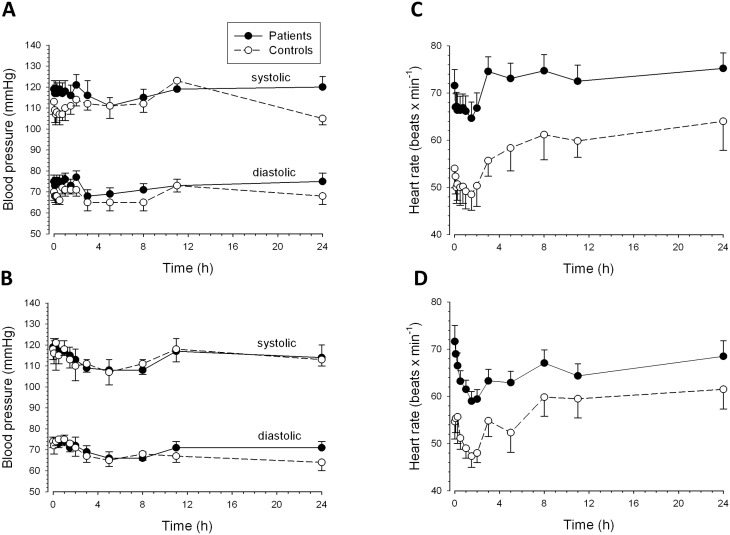
Effect of propranolol on non-invasive hemodynamic variables.Blood pressure vs. time curves after (A) intravenous (1 mg); and (B) oral (40 mg) application and heart rate vs. time curves after (C) intravenous (1 mg) and (D) oral (40 mg) application of propranolol. The values at 48 h are not shown since they were not significantly different from those at 24 h.